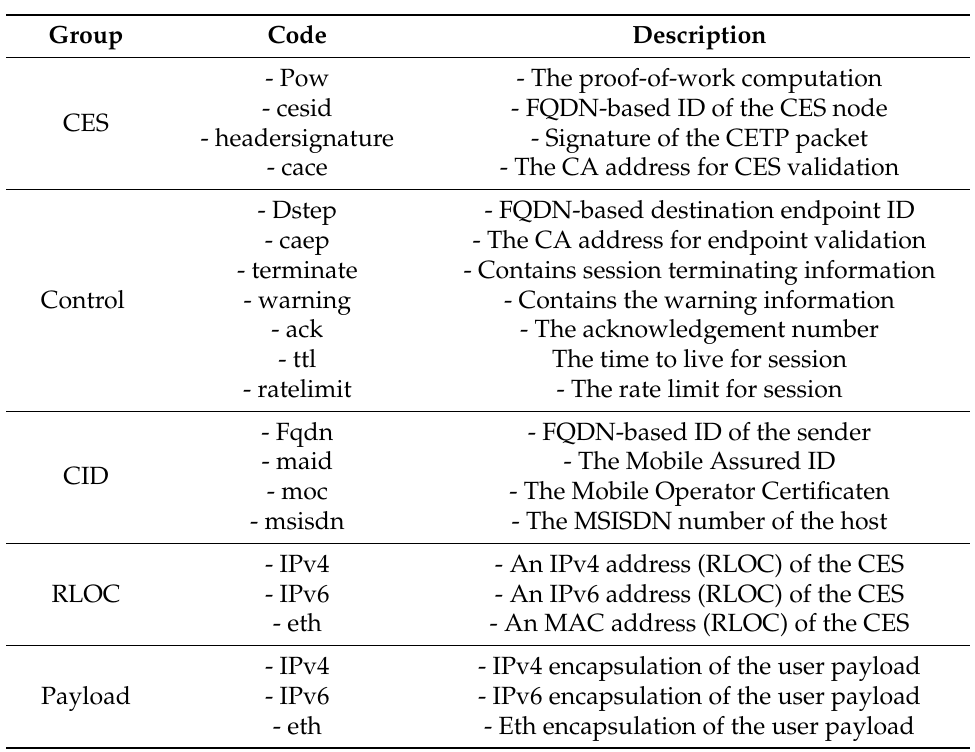
Figure 4. CETP control plane structure [8]. Table 2. CETP policy elements